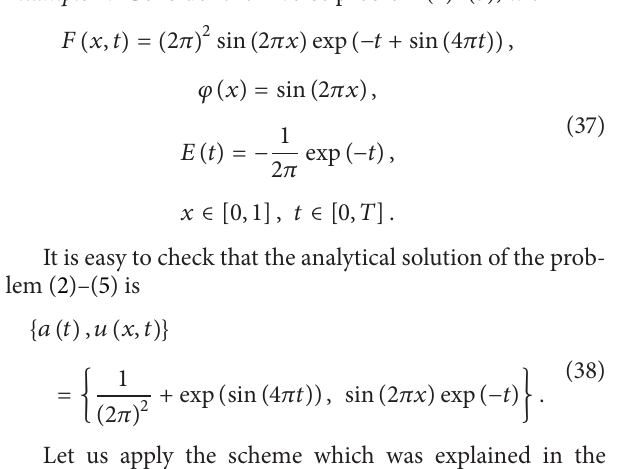
Figure3:Theanalyticalandnumericalsolutionsof 𝑎(𝑡) when 𝑇 = 1 . The analytical solution is shown with dashed line.